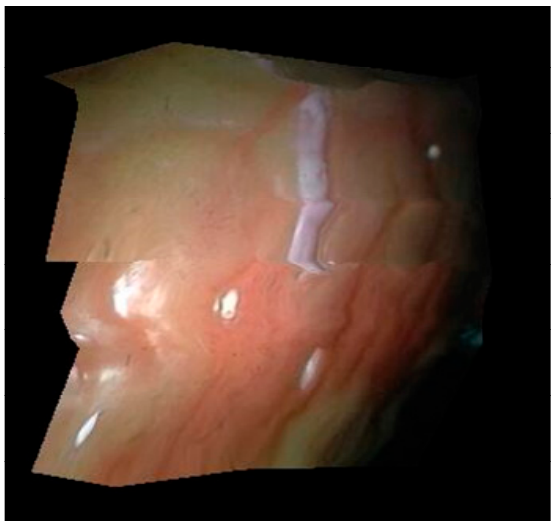
Figure 12. 3D curved surface reconstruction result.